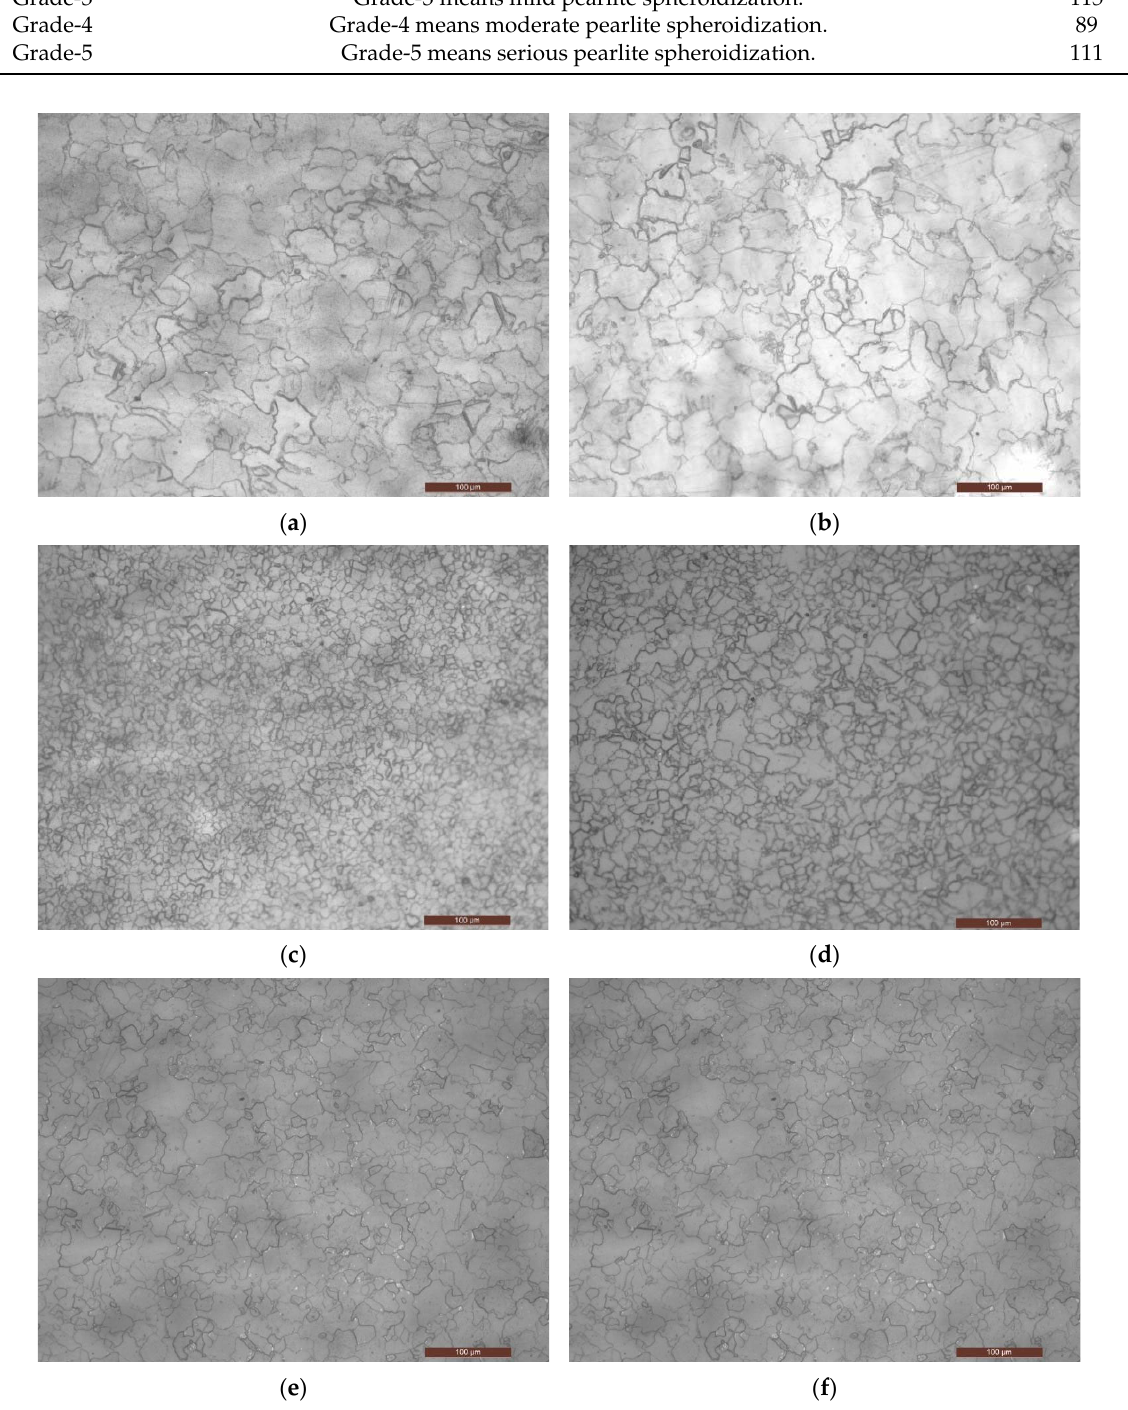
Figure 6. Problems with spherular pearlite gradation. Some images appear very similar but are labeled using different grades. ( a ) Normal; ( b ) Grade ‐ 5; ( c ) Normal; ( d ) Grade ‐ 5; ( e ) Grade ‐ 4 (elbow); ( f ) Grade ‐ 5 (body). Table 2. Image numbers for spherular pearlite gradation with each class. Classes Explanation Normal Grade ‐ 1 and Grade ‐ 2 mean that pearlite spheroidization has not occurred.